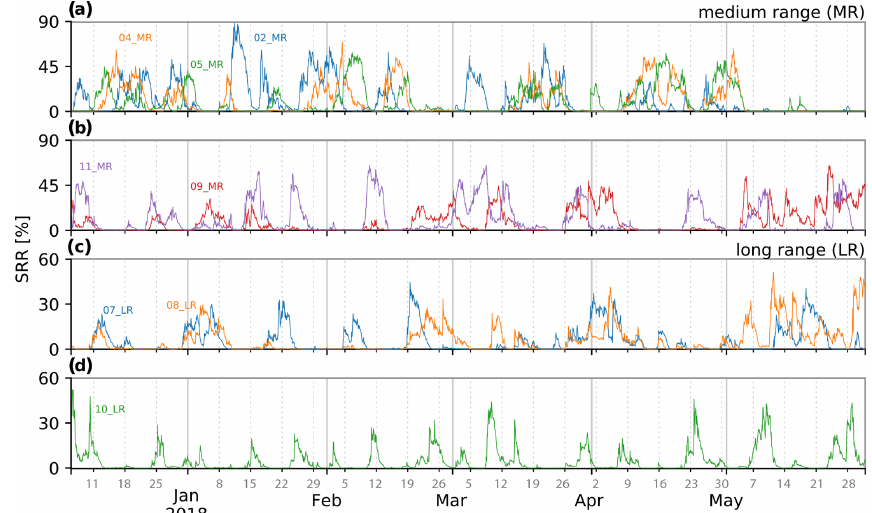
Figure 12. Time series of the SRR [%] cluster influence (similar to Fig. 11). Panels (a) and (b) show the MR clusters. Panels (c) and (d) display the LR clusters.